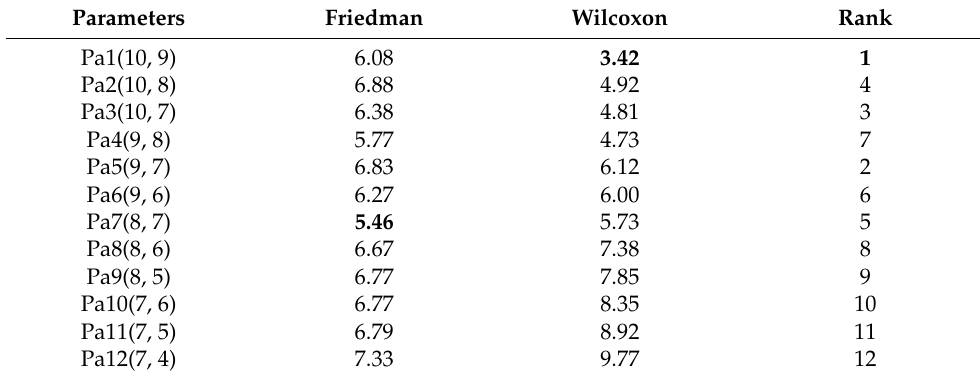
Table 4. The Friedman and Wilcoxon results in different